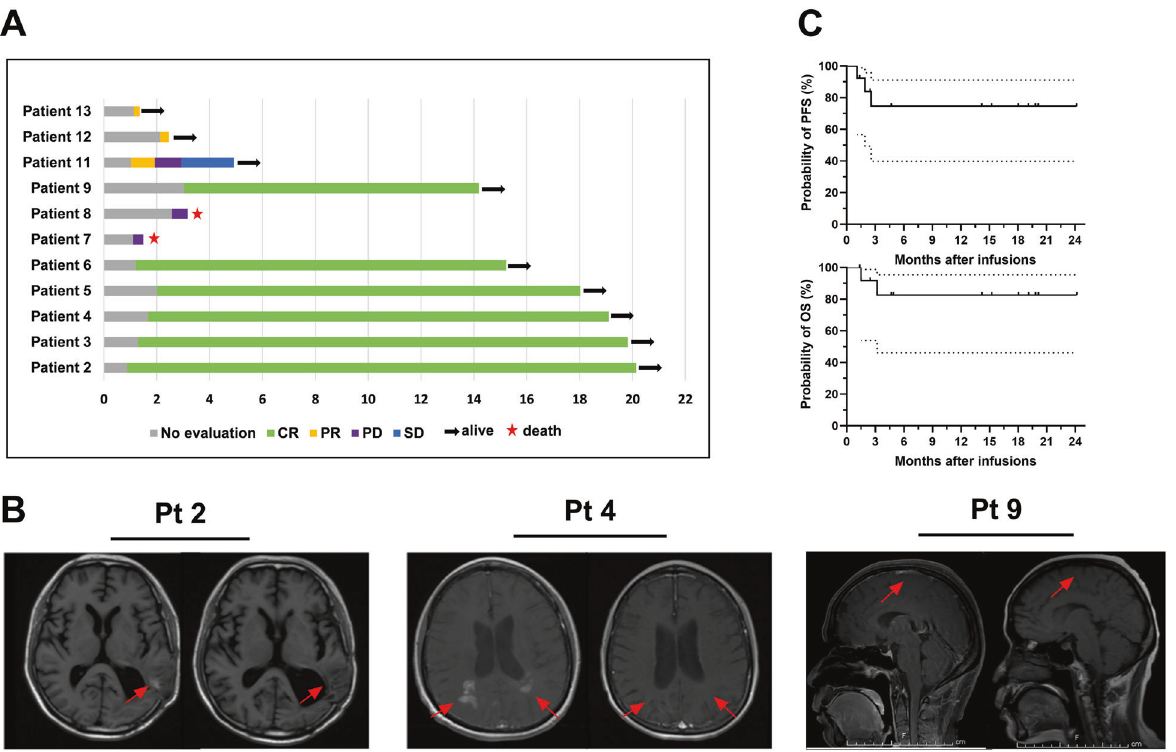
Fig. 2 Descriptions of the clinical results. A The clinical outcomes (excluded patient 1 and 10), the last visit day was March 15, 2020. B Representative MRI imaging before (left) and after (right) therapy. C The probability of PFS and OS. The median PFS and OS of patients were unde fi ned, the 1-year estimated PFS and OS rate were 74.59% (95% CI: 39.76 – 91.10%) and 82.50% (95% CI: 46.10 – 95.33%), respectively.